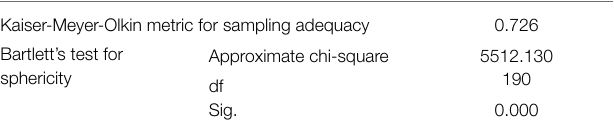
TABLE 4 | Validity analysis results.